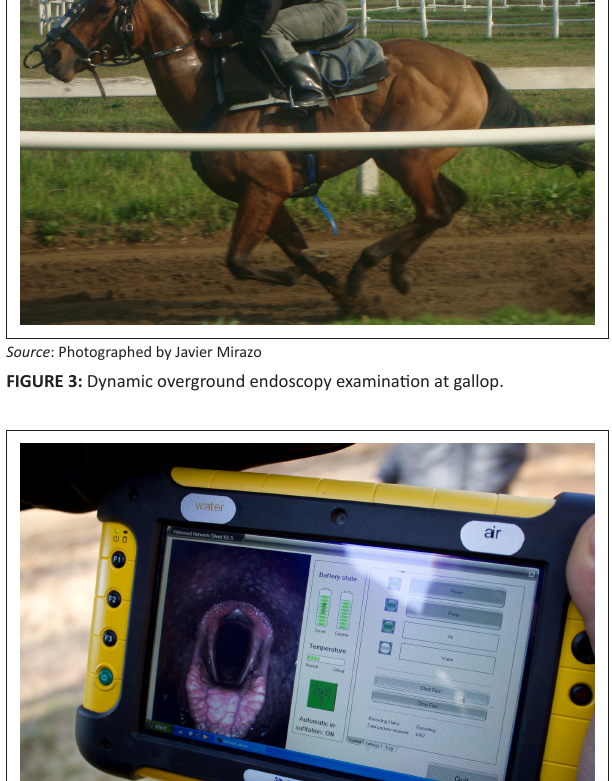
TABLE 1: Number of abnormalities detected by dynamic overground endoscopy in relation to presenting complaint in 52 Thoroughbred racehorses examined from November 2011 to August 2012 in South Africa. Primary